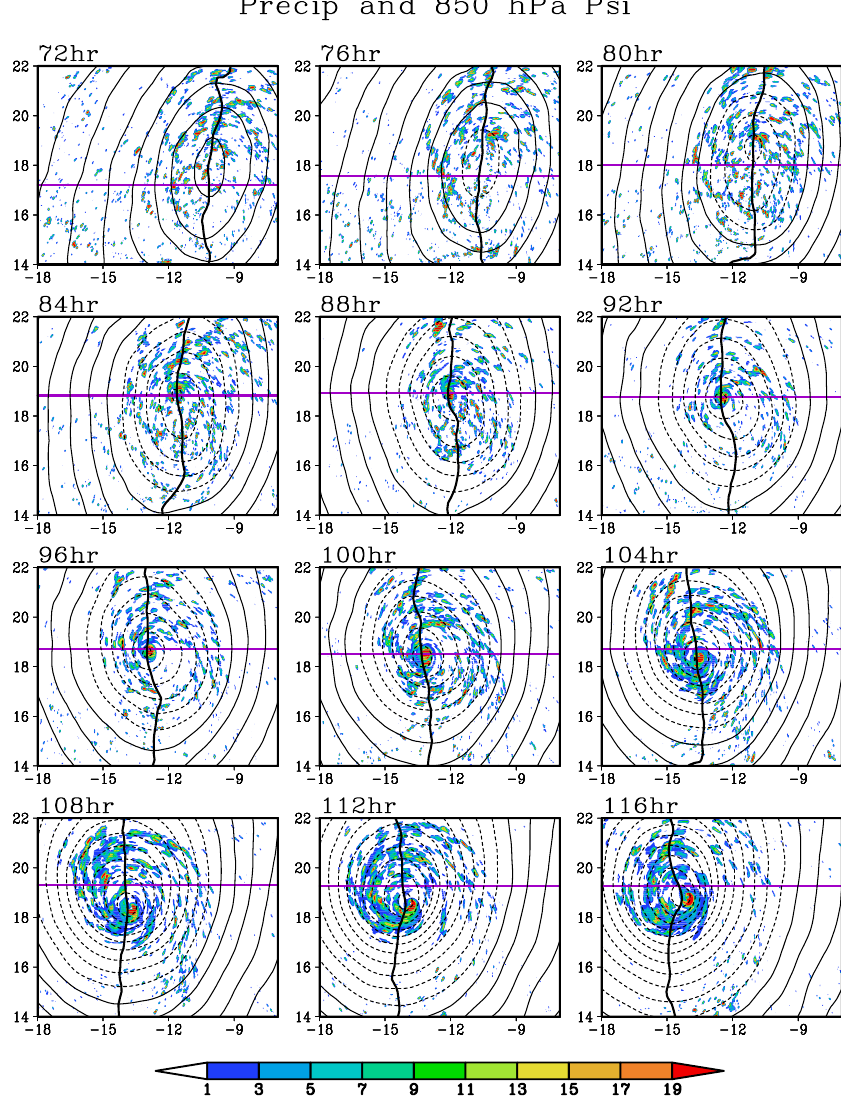
Fig. 12. Evolution of translated stream function and precipitation (shading; units: mm/h) from the inner grid (3 km resolution) simulation from Hour 72 to Hour 116. The zonal straight line indicates the critical latitude and the meridional black curve represents the trough axis. The ordinate is latitude and the abscissa is longitude.